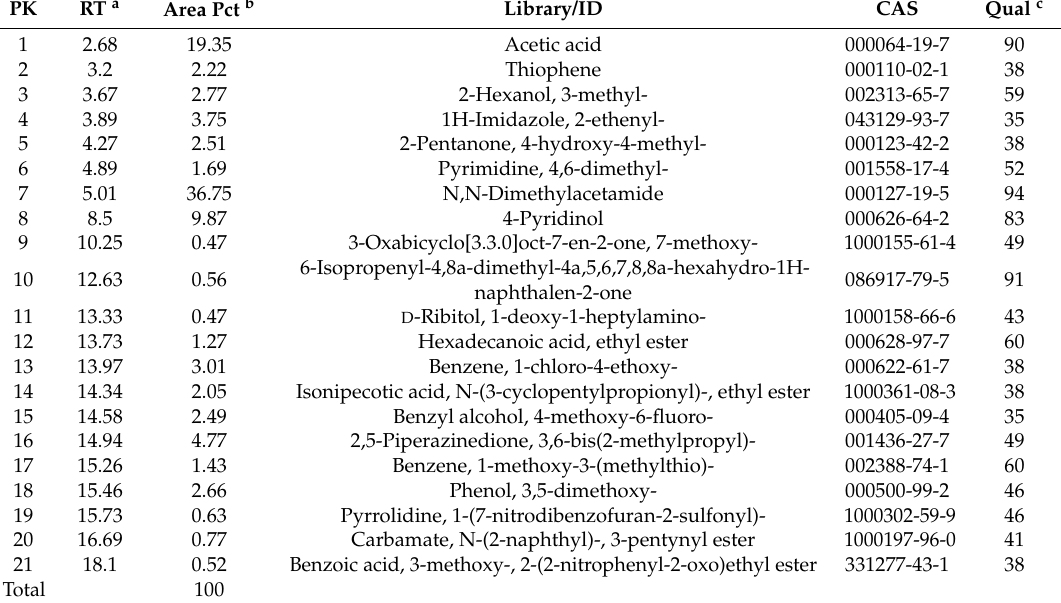
Table 3. Gas chromatography–mass spectrometry (GC-MS) results of the bio-crude oil obtained from HTL of TPW in water–ethanol medium at 250 ◦ C, 30 min with H 2 SO 4 catalyst. PK RT a Area Pct